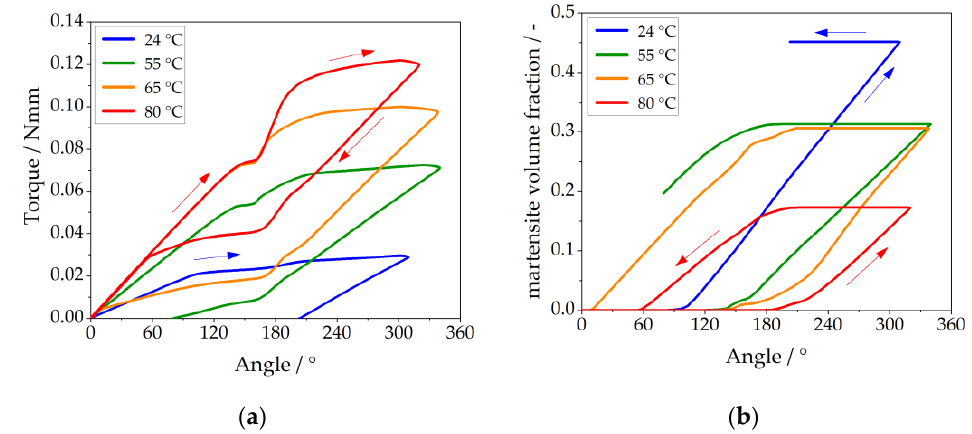
Figure 10. ( a ) FEM simulation of torque versus folding angle of a single microactuator for different homogeneous temperatures as indicated; ( b ) corresponding local martensite volume fraction versus folding angle in the bending region.